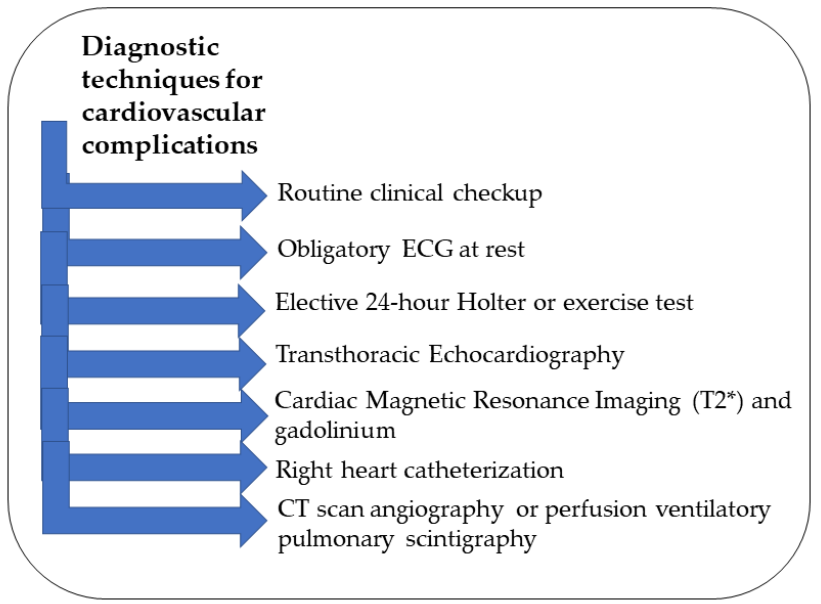
Figure 2. Summary of the different diagnostic techniques for cardiovascular complications.